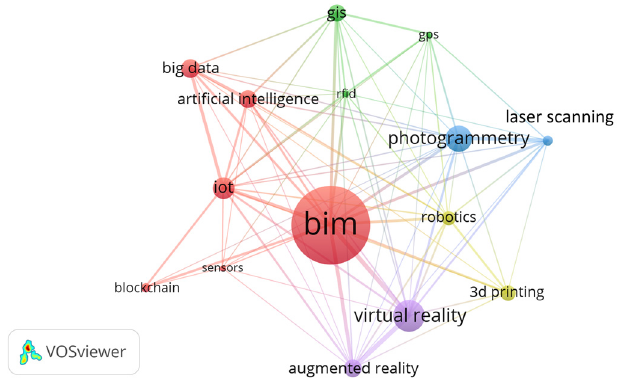
Figure 2. Visualization of keywords occurrences of digital technologies in the construction industry.